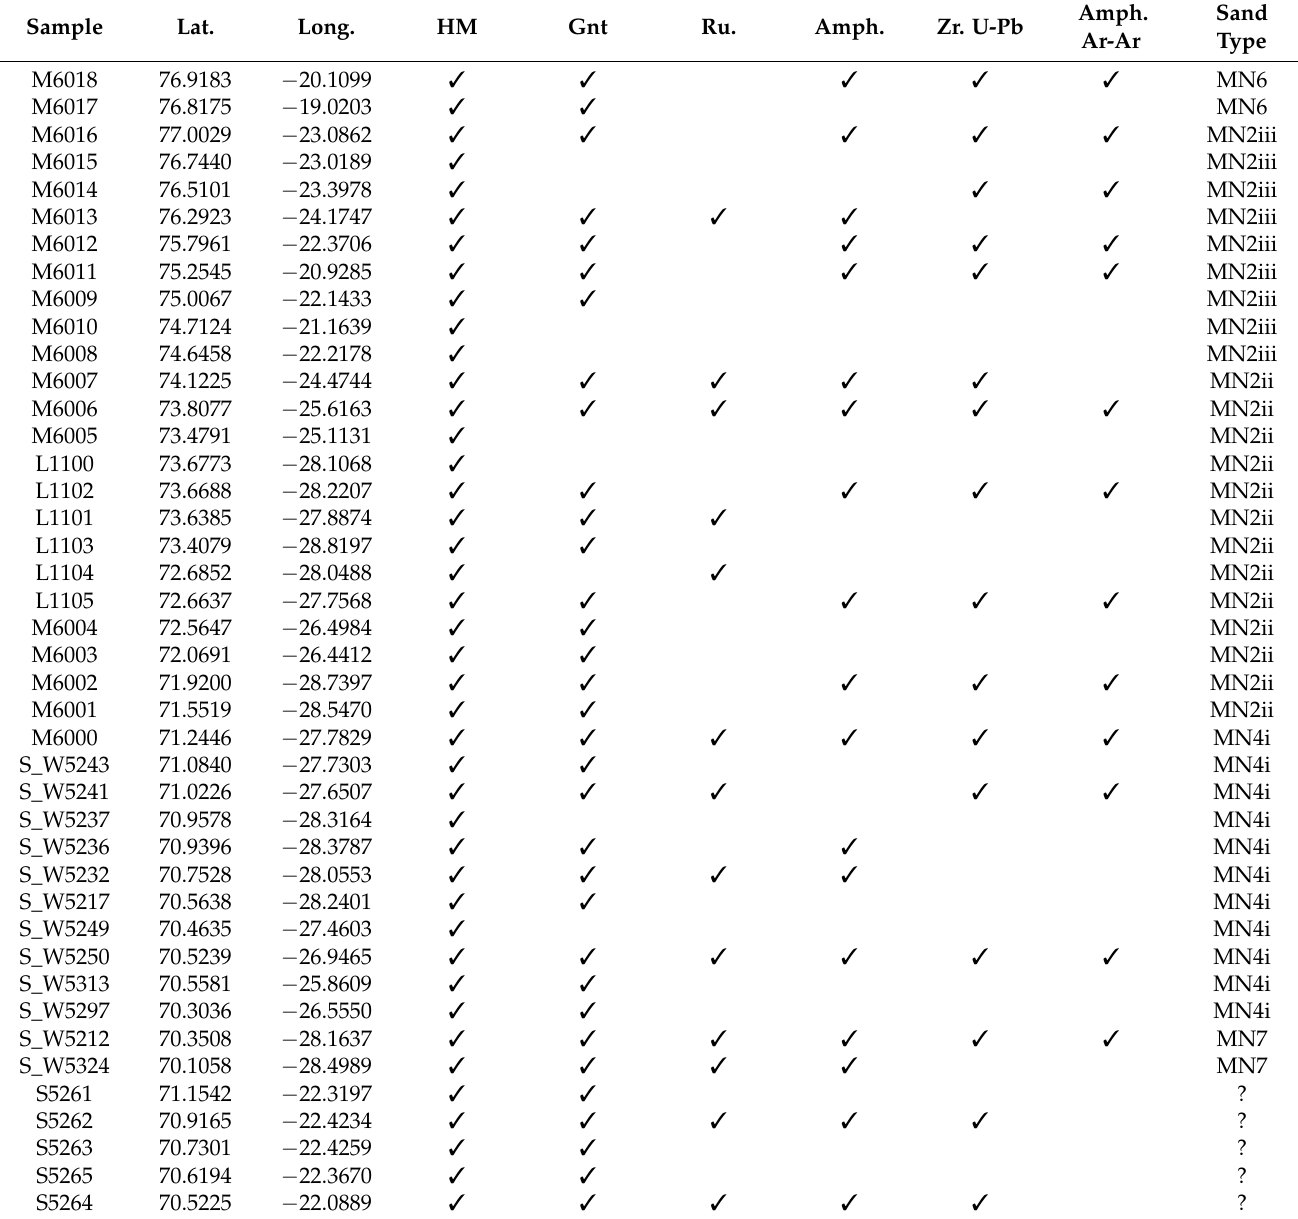
Table 1. Moraine/outwash sample list, with analytical techniques and sand type assignations. HM: heavy mineral